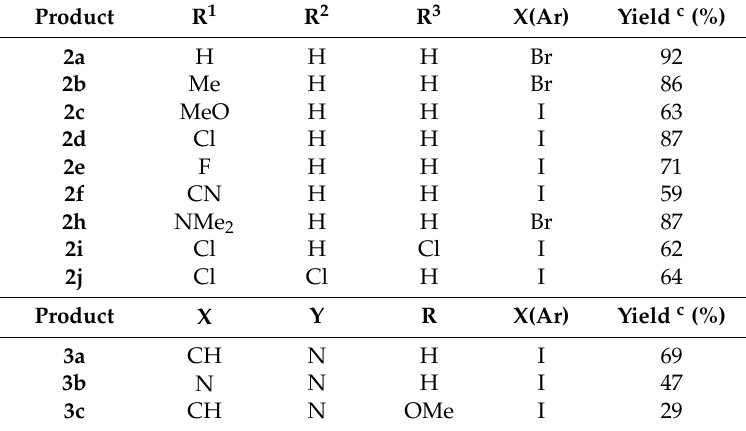
Table 1. Chemical structures and yields obtained for the synthesis a of series 2a – j (R 1 , R 2 , and R 3 ) and 3a – c b (R, X, and Y).